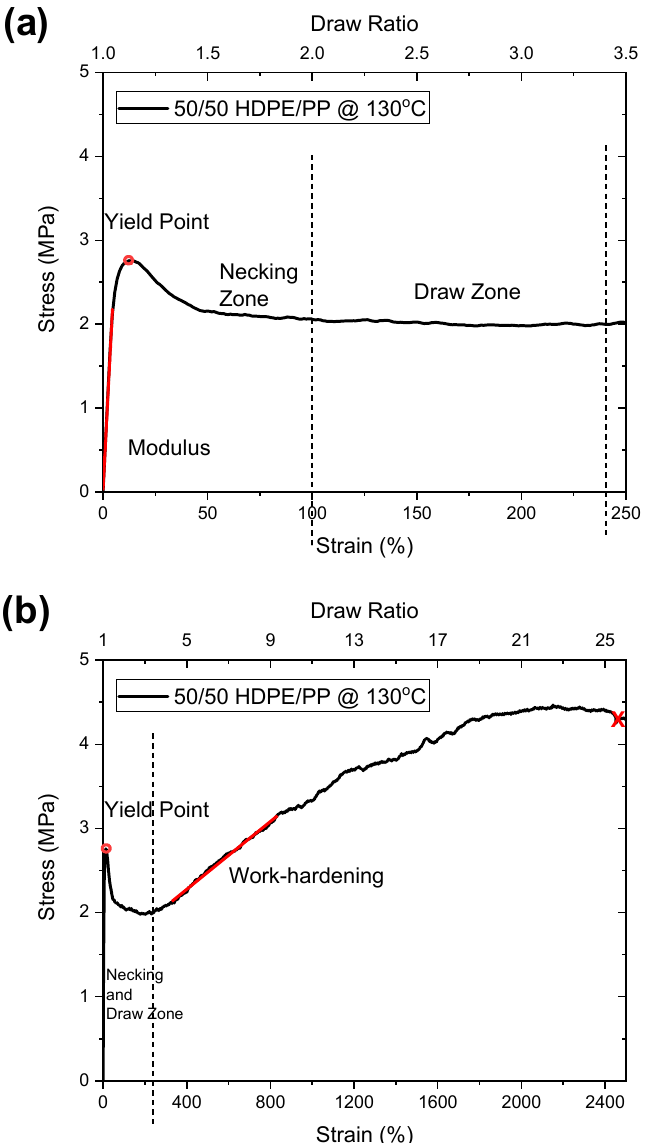
Figure 6. Stress–strain curve during high-temperature orientation of 50/50 PP/HDPE tape at 130 °C; ( a ) is an enhanced portion of ( b ) in the 0–250% region. “X” indicates location of specimen fracture.